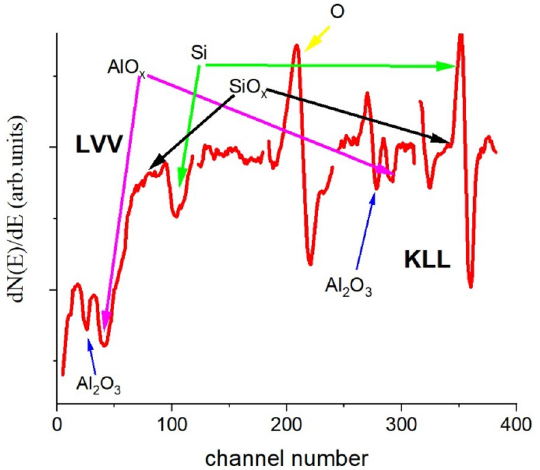
Figure 2. The differentiated, N(E)’, Auger electron spectrum of 5 nm Al 2 O 3 /Si substrate sample recorded in a depth of 3.2 nm (measured from the free surface) after the irradiation of 500 nA and 16 h. The temperature of the sample during irradiation was 500 °C. AlO x stands for Al suboxide. The black arrows labelled SiO x show the position where the silicon suboxide peak should be (in fact here they are absent). The peaks belonging to LVV and KLL transitions are indicated.